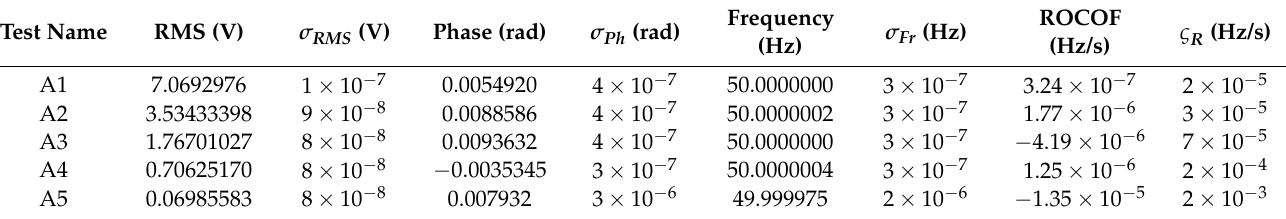
Table 15. Measurement results of the amplitude tests.